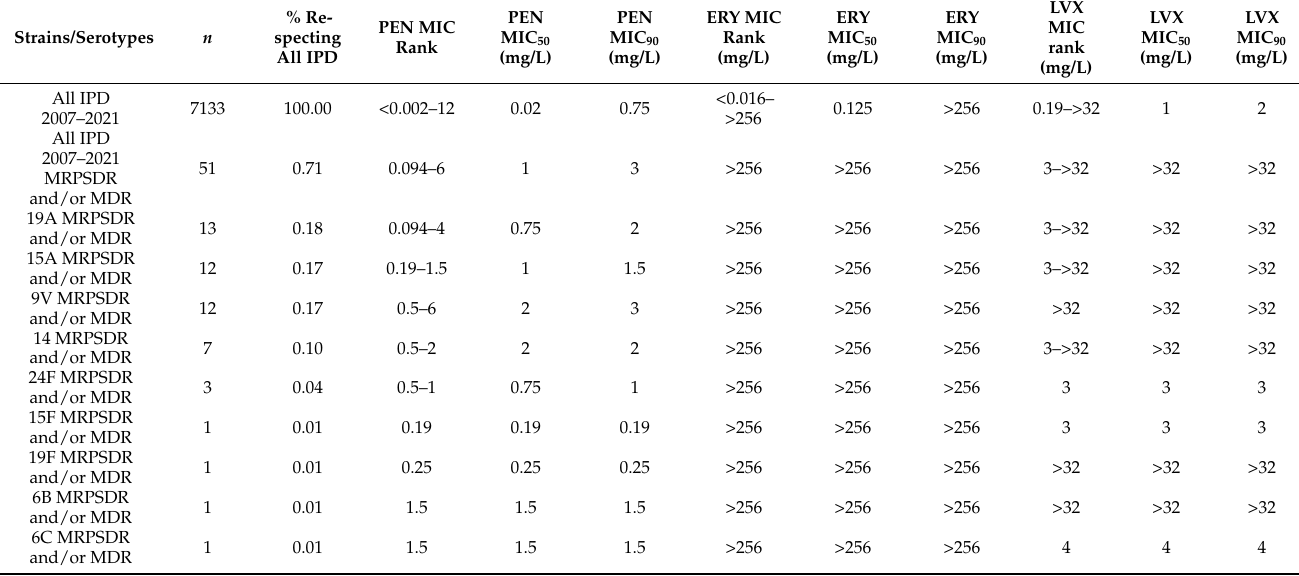
Table 3. MIC50 and MIC90 of PEN, ERY and LVX for all IPD cases and for multidrug-resistant strains at standard dosing regimen of penicillin and/or MDR serotypes in the Madrid Region for the period 2007 to